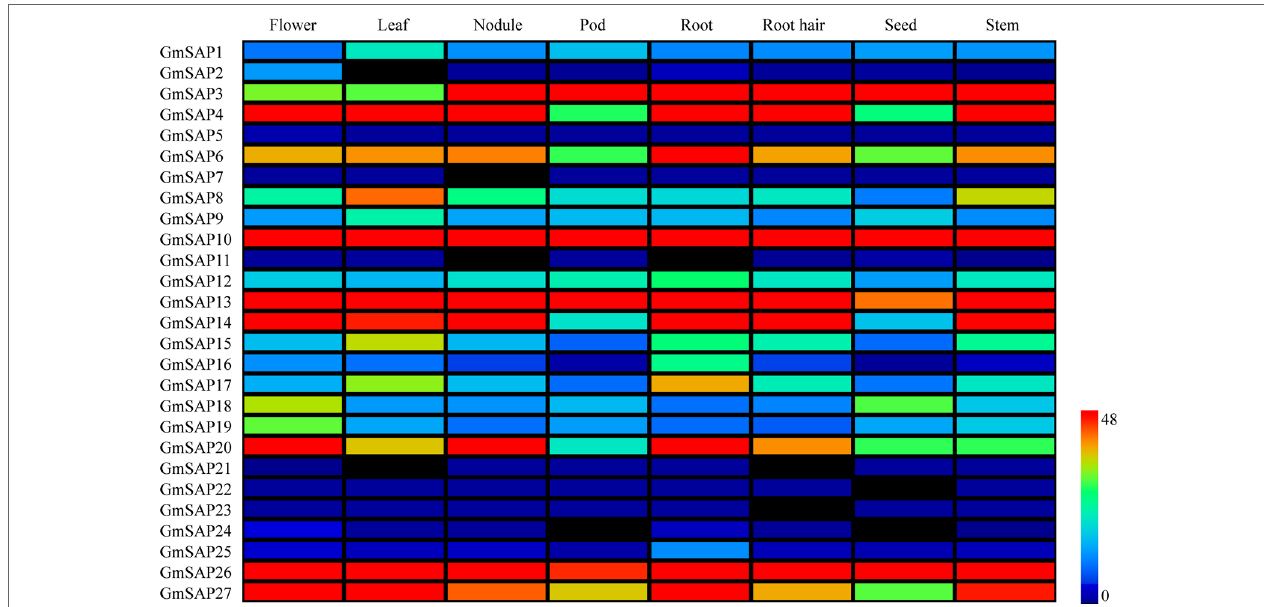
FiGURe 3 | Patterns of soybean stress associated protein (SAPs) transcript accumulation in various soybean tissues (flower, leaf, nodule, pod, root, root hair, seed, and stem). The transcript level data of the soybean SAP genes were obtained from Phytozome. A heatmap was generated using MeV_4_9_0 software. Transcript levels are indicated by different colors on the scale